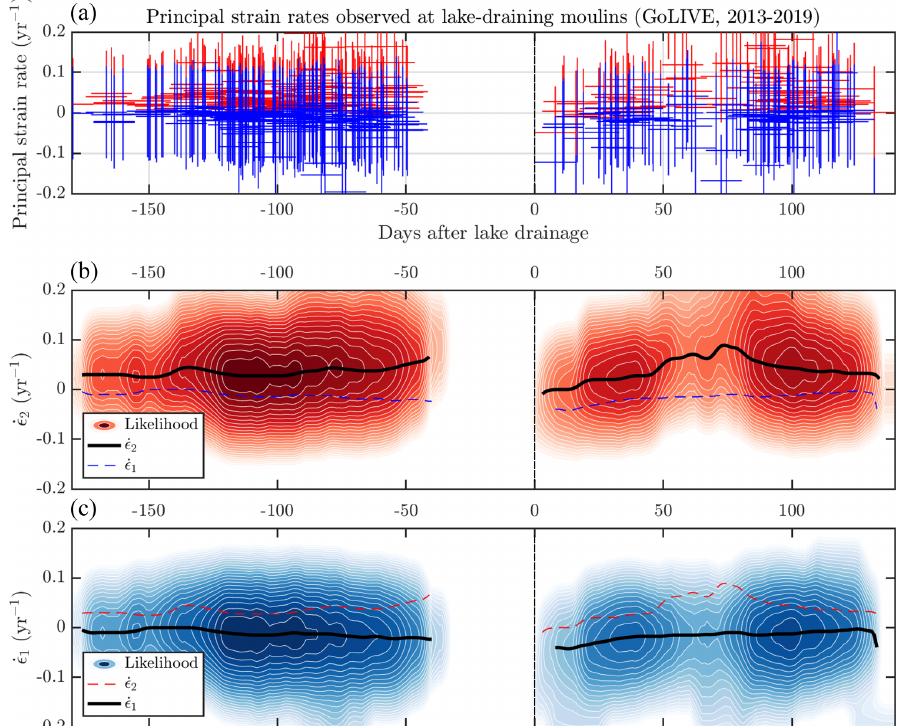
Figure 12. (a) Strain rates at moulins connected to 144 fast-draining lake events over the period 2013–2019, calculated from the GoLIVE Landsat 8-derived velocity product (Scambos et al., 2016; Fahnestock et al., 2016) with time resolution of 16d. Blue lines are more compres- sional principal strain rates, ˙ (cid:15) 1 , with error bars in strain rate and time; red lines are more extensional principal strain rates, ˙ (cid:15) 2 . This dataset covers the entire Pâkitsoq region. (b) The number of observed ˙ (cid:15) 2 displayed as a heat map, with number of observations (colored background) versus strain-rate magnitude ( y axis) and number of days before or after each individual fast-draining lake event ( x axis). Darker colors indi- cate more likely values of strain rate. (c) The number of ˙ (cid:15) 1 displayed as a heat map. These data represent 97 velocity scene pairs, differenced to obtain regional strain-rate observations and interpolated onto the moulin sites before, during, and after 144 fast-draining lake events into those moulins over this 7-year period. The black, red, and blue lines plot the time series of the most likely principal strain rates ˙ (cid:15) 1 and ˙ (cid:15) 2 , inferred directly from the data shown in the heat maps. The presence of water during the melt season interferes with the production of the GoLIVE observations from roughly 40d before most lake drainages through roughly 10d